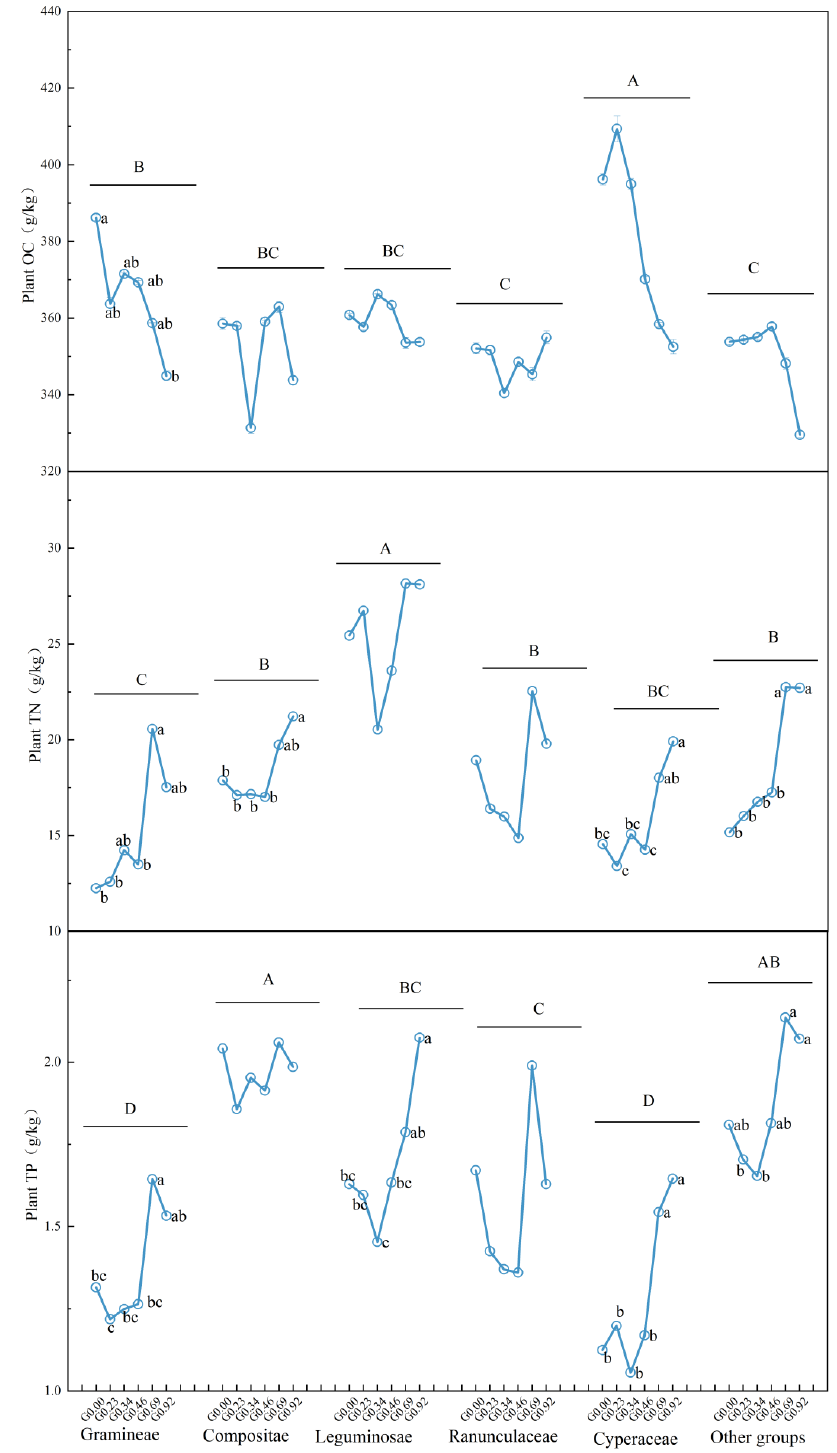
Figure 2. Variation in the nutrient content of plant functional groups under different grazing intensities. Note: Lowercase letters represent significant differences between different grazing intensities, and uppercase letters represent significant differences between functional groups ( p < 0.05).